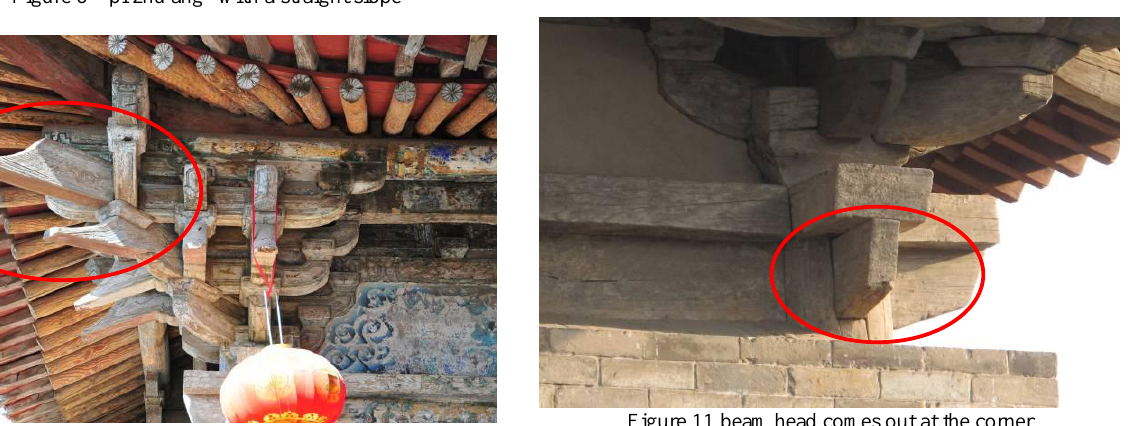
Figure 9 “qin mian ang” with a gently curved arc